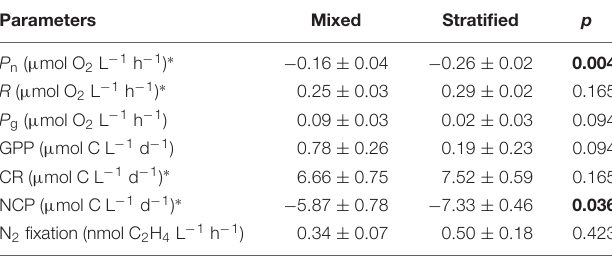
TABLE 2 | Primary production ( P n , R and P g , GPP, CR and NCP) and N 2 fixation in the mixed and stratified periods. Parameters Mixed